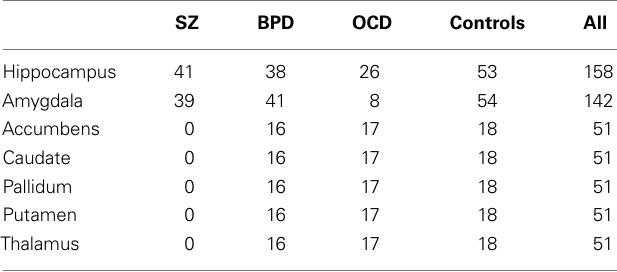
Table 2 |Available ROI volumes per region and group